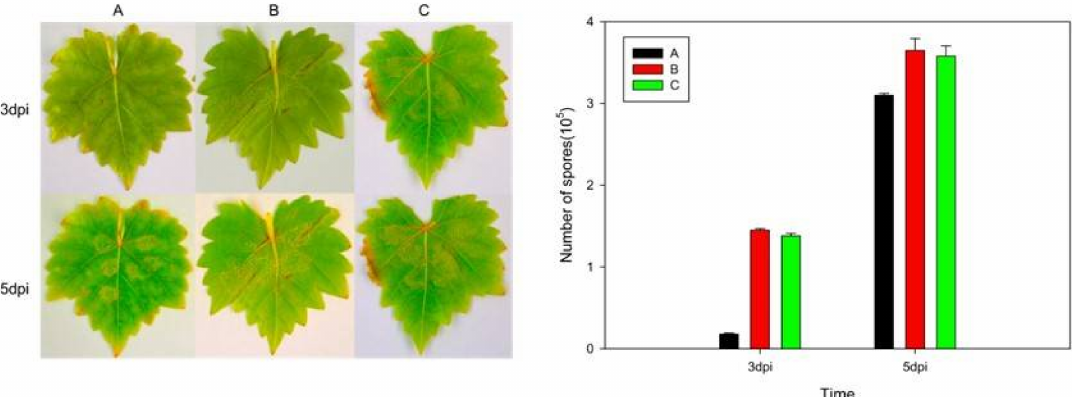
Figure 7. Phenotypes of leaves from Vitis vinifera after infection with Plasmopara viticola . ( A ) V. vinifera expressing VaHAESA ; ( B ) V. vinifera transformed with the empty vector (pBI121); ( C ) untransformed V. vinifera “Thompson Seedless”. The representative images were taken three and five days post-infection (dpi) with Plasmopara viticola